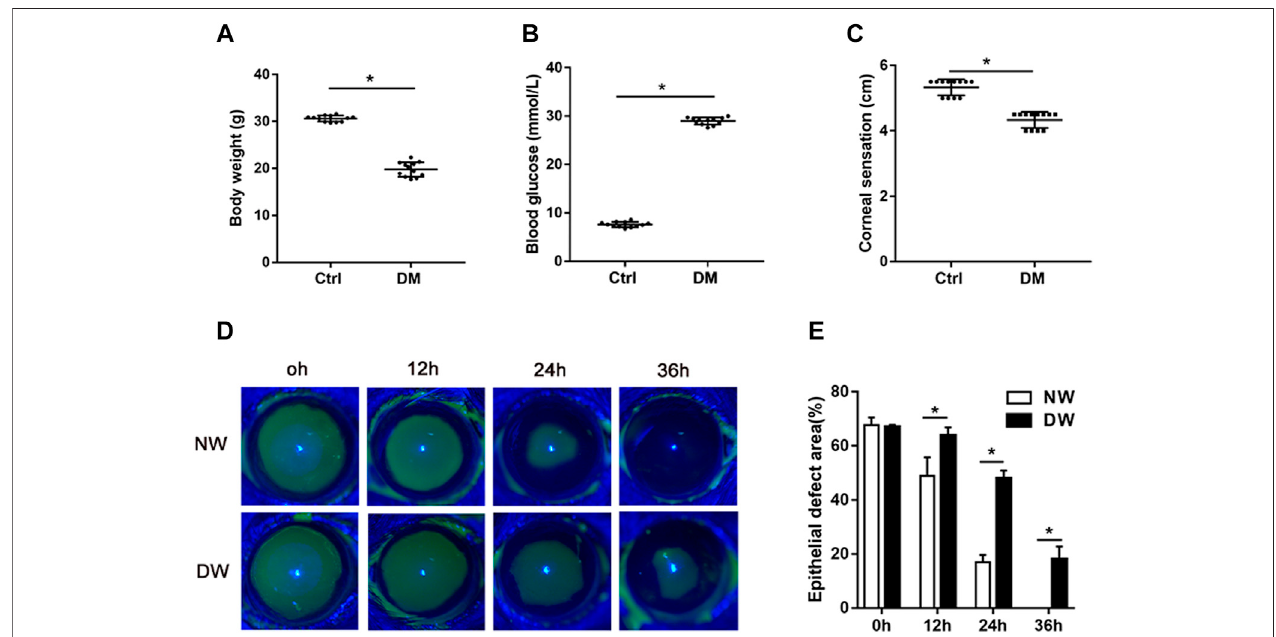
FIGURE 1 | T1DM animal model and general phenotypes. (A) The body weight, (B) blood glucose levels, and (C) corneal sensation levels of normal (Ctrl) and diabetic(DM)mice. (D) Fluorescence stainingassay wasused torecord thewoundhealingprocess ofnormal mice withcorneal epithelialinjury(NW group) and diabetic mice with corneal epithelial injury (DW group). (E) The epithelial defect areas were calculated by Image J software. Data were analyzed by unpaired t-test. * p -value of < 0.05.